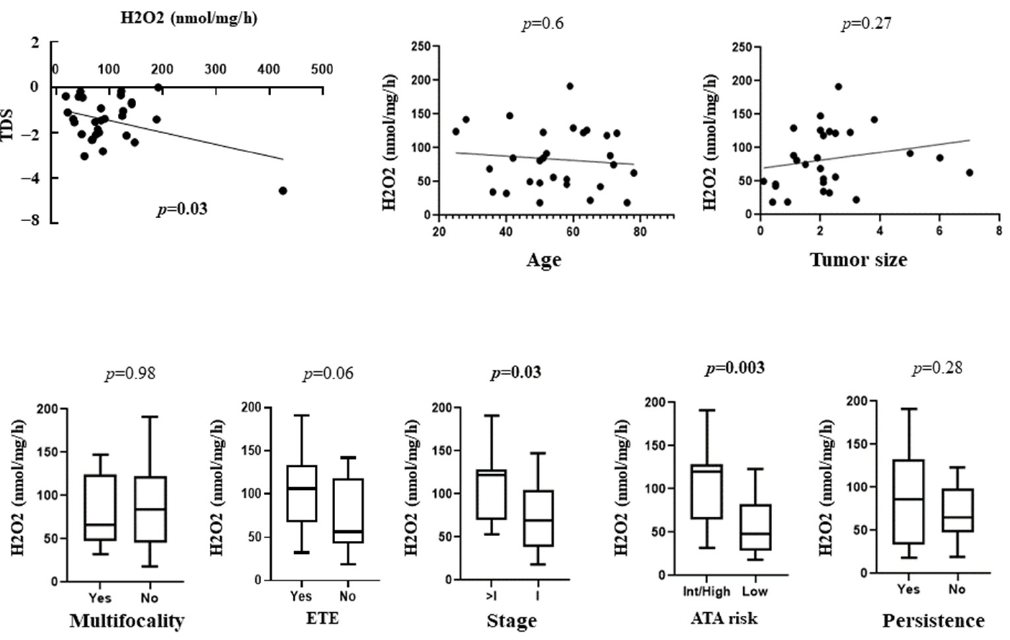
Figure 3 . Correlation between H 2 O 2 generation levels and TDS and clinical and prognostic features of the patients with differentiated thyroid cancer. TDS = thyroid differentiation score; ETE = extrathyroidal extension; ATA = American thyroid association.